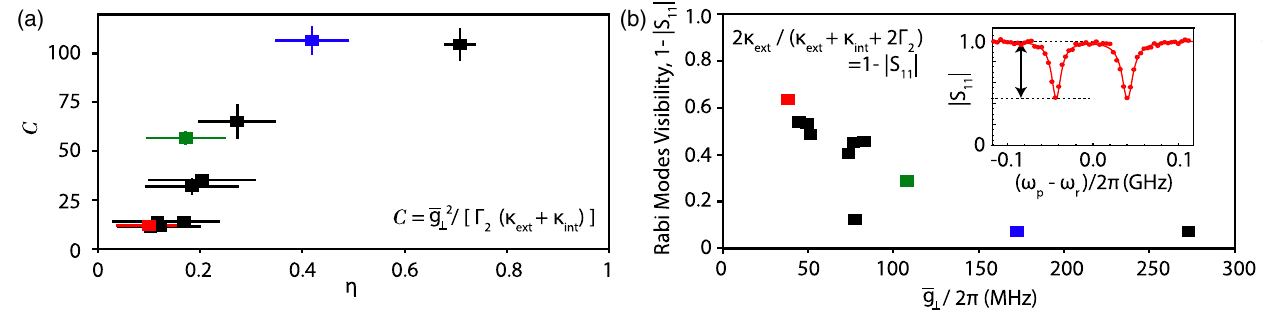
κ . (b) Visibility of the ext þ int Þ(cid:2)